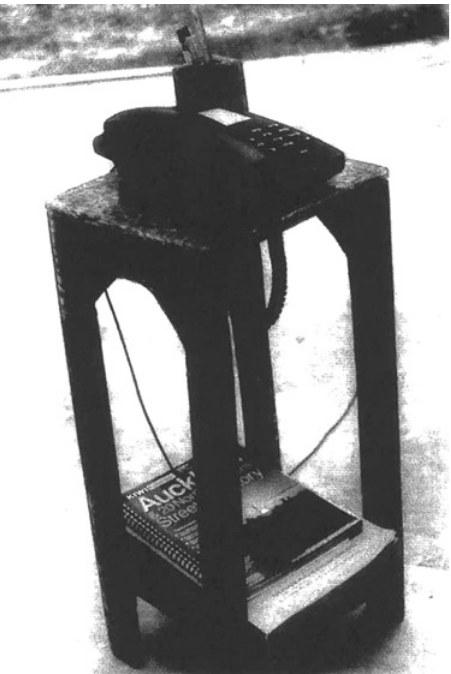
Figure 18: Actual banana woven fabric composite telephone stand